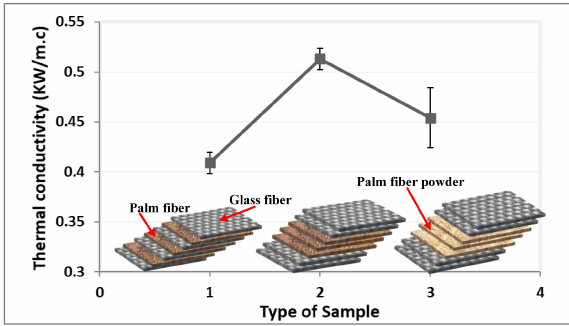
Fig. 9. Effect of fiber layers (arranging and form) on the thermal conductivity.